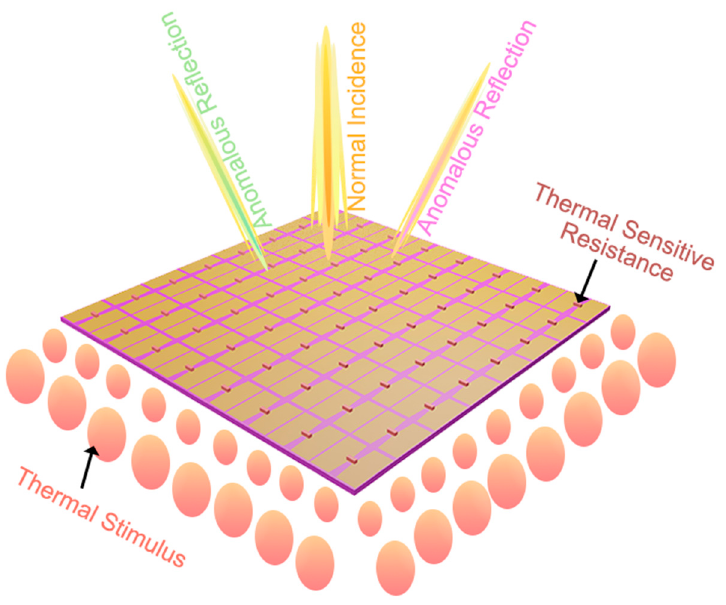
Figure 1. Schematic illustration of a temperature-sensitive metasurface. When a metasurface con- taining a thermistor experiences an external thermal stimulus, its reflection phase pattern is repro- grammed, resulting in anomalous reflection